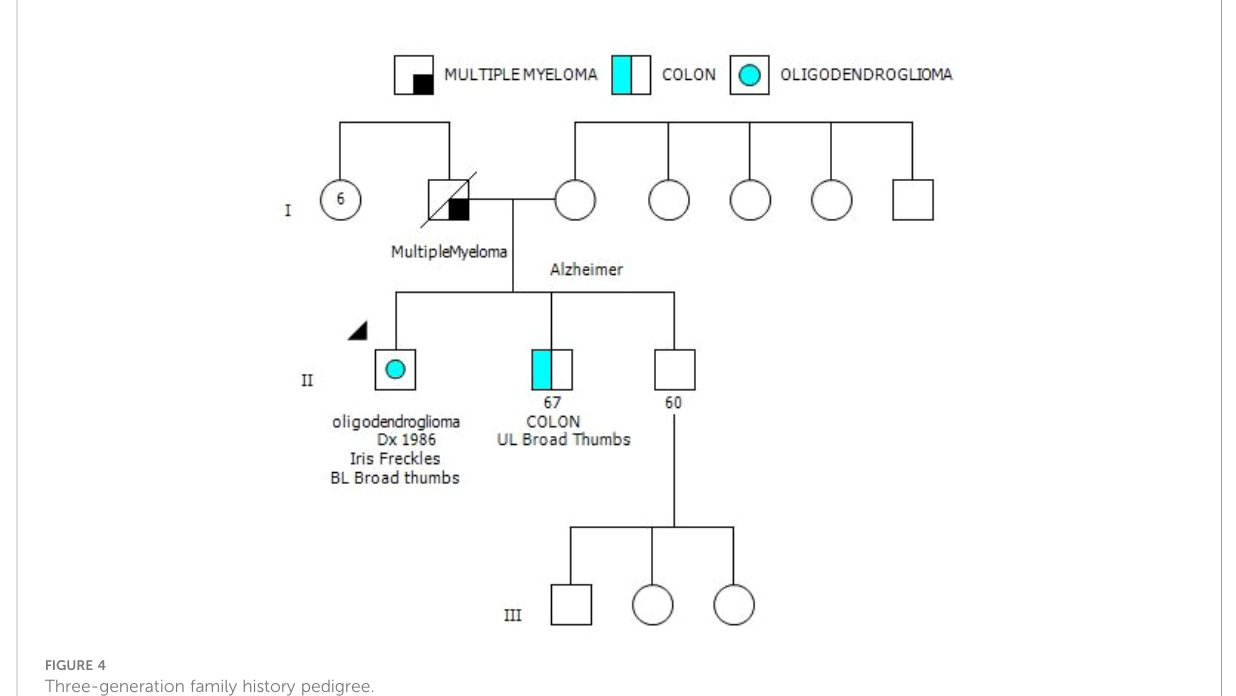
FIGURE 4 Three-generation family history